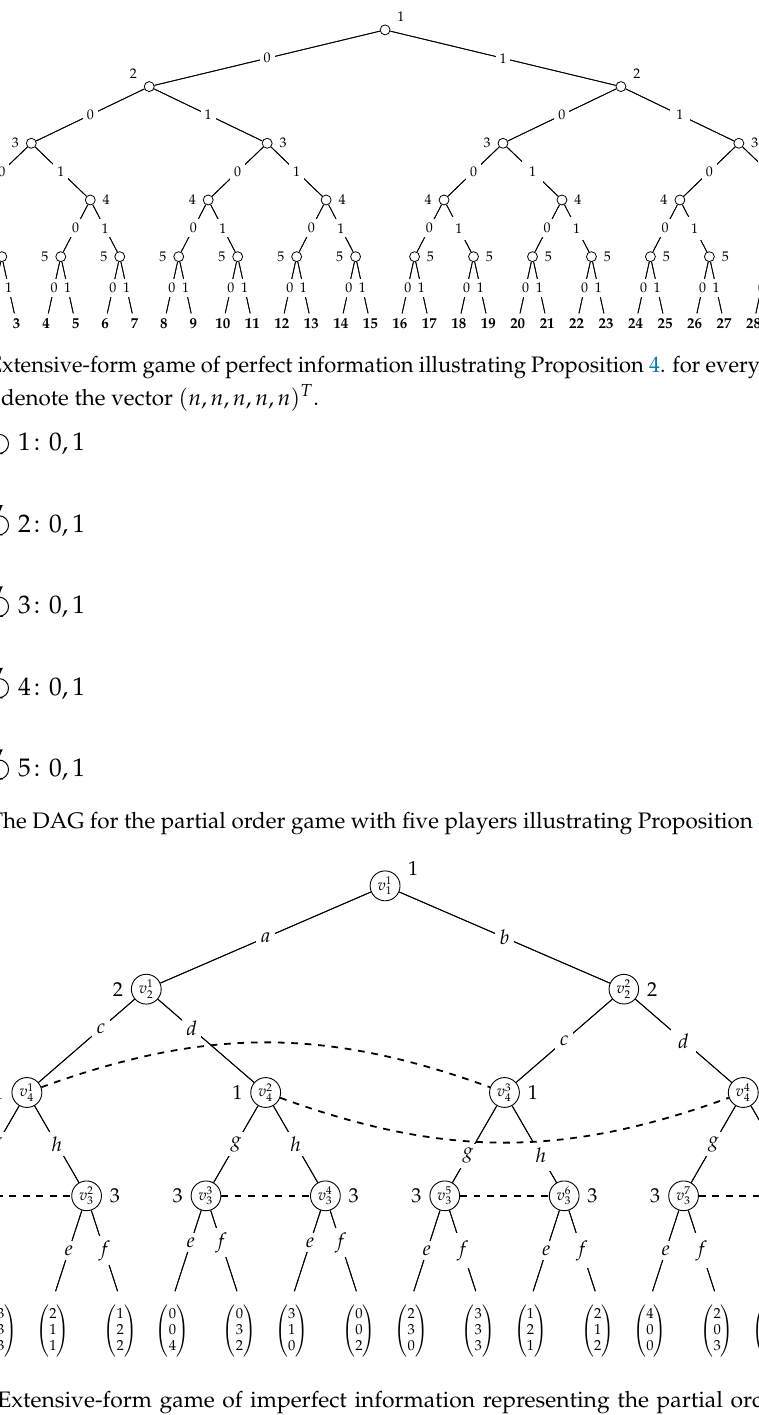
Figure 9. Extensive-form game of imperfect information representing the partial order game in Figure 3 assuming topological ordering ( v 1 , v 2 , v 4 , v 3 ) . The dashed lines connecting vertices indicate the information